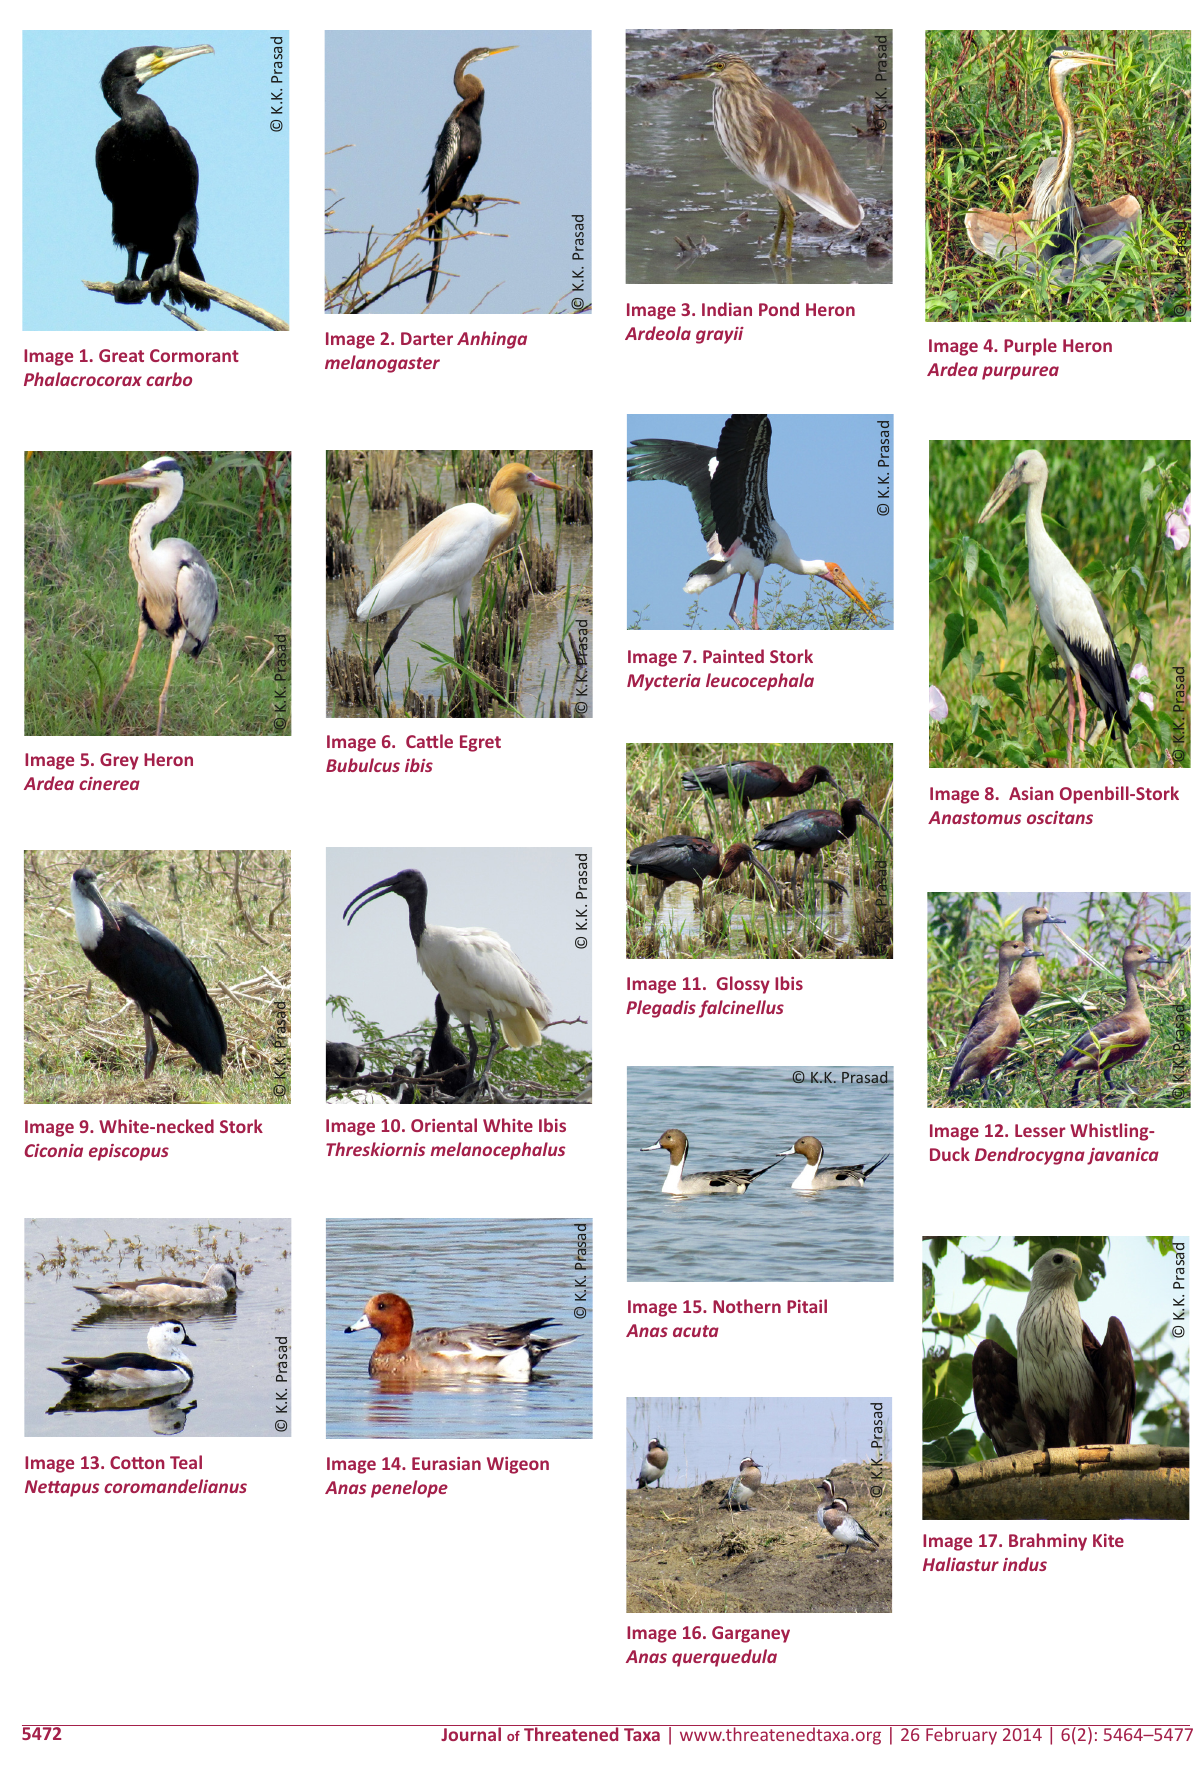
Image 16. Garganey Anas querquedula